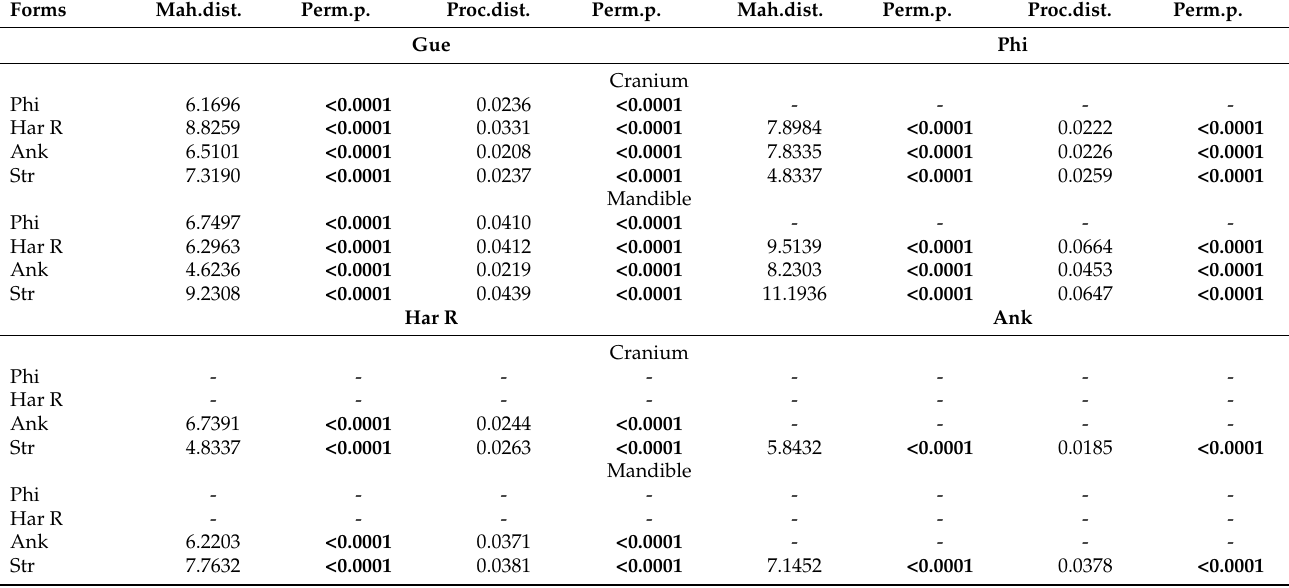
Table 6. CVA results for cranial and mandibular datasets among five vole forms (Mah. Dist.: Mahalanobis distance; Proc. Dist.: Procrustes distance; Perm. P: permutation p value; boldfaced: